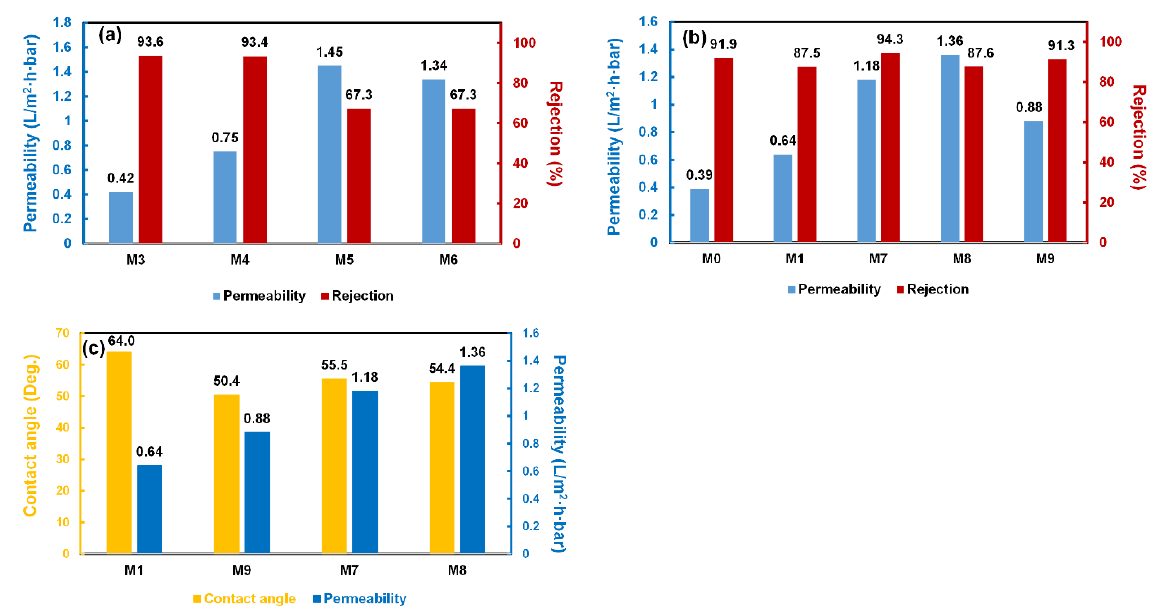
Figure 4. Filtration performance of the prepared and reference membranes: ( a , b ) the permeability and rejection, and ( c ) the contact angles and permeability of the membranes.